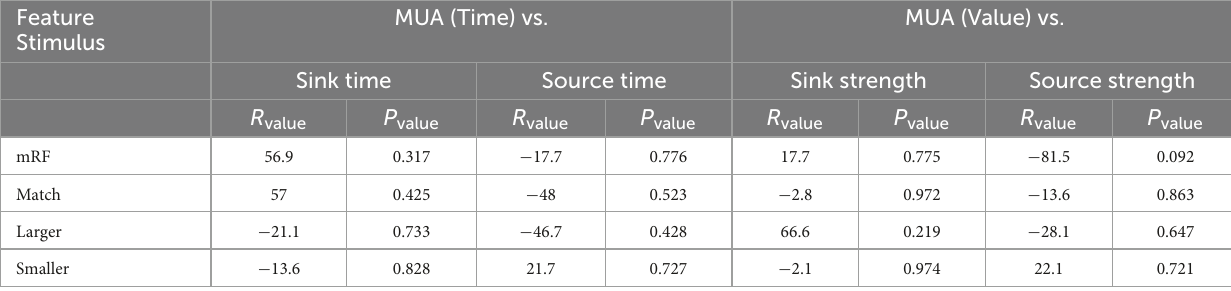
TABLE 6 The correlation between multiunit activity (MUA) and current source density (CSD) across layers. Feature MUA (Time) vs. MUA (Value) Stimulus